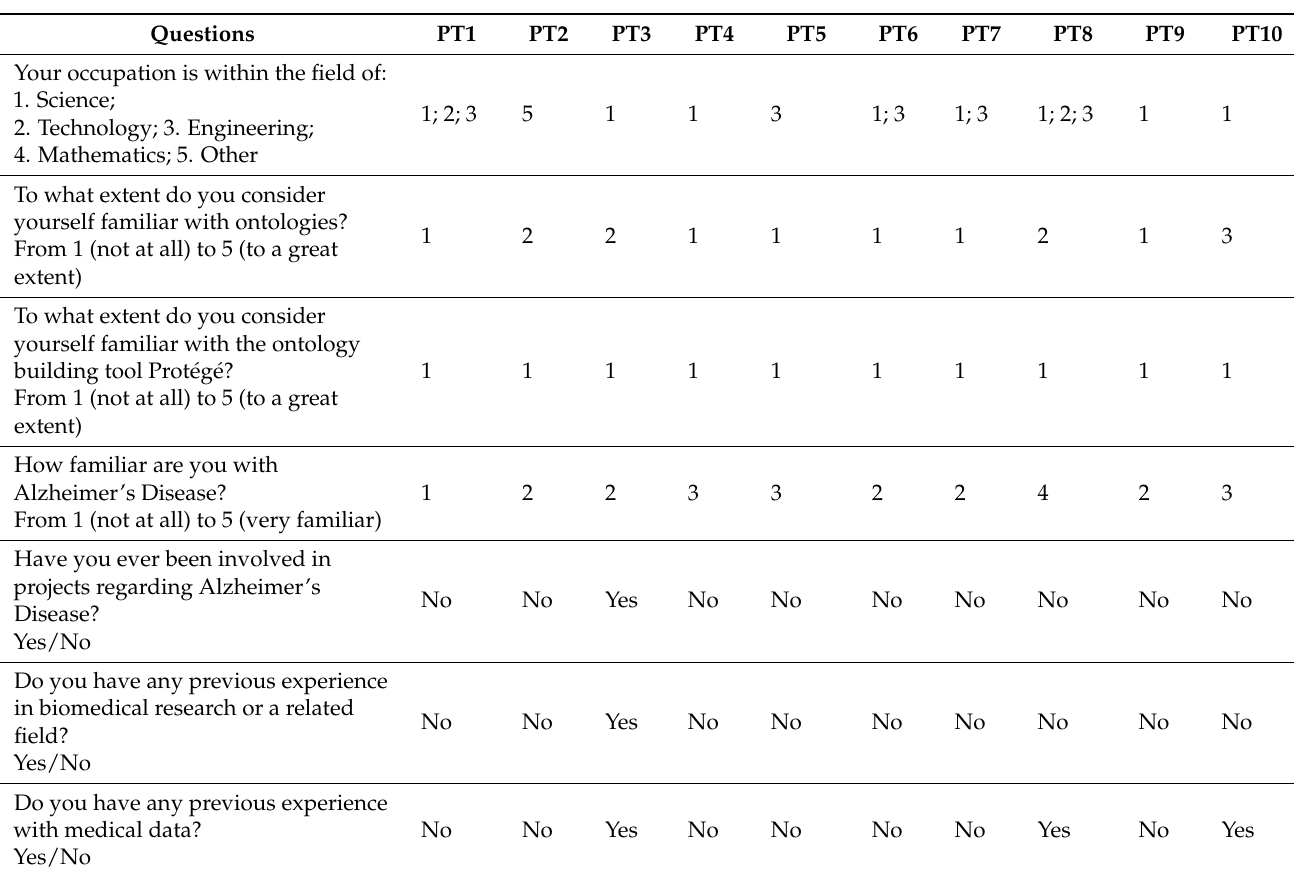
Table 2. Baseline knowledge and prior experience questionnaire. All included questions are depicted with the respective answers provided by each participant. Note that only the first question allowed multiple